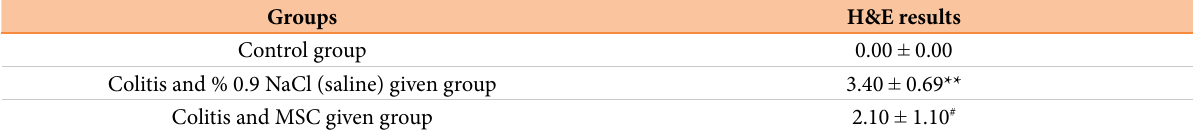
Table 2 - The results of histopathological parameters*.